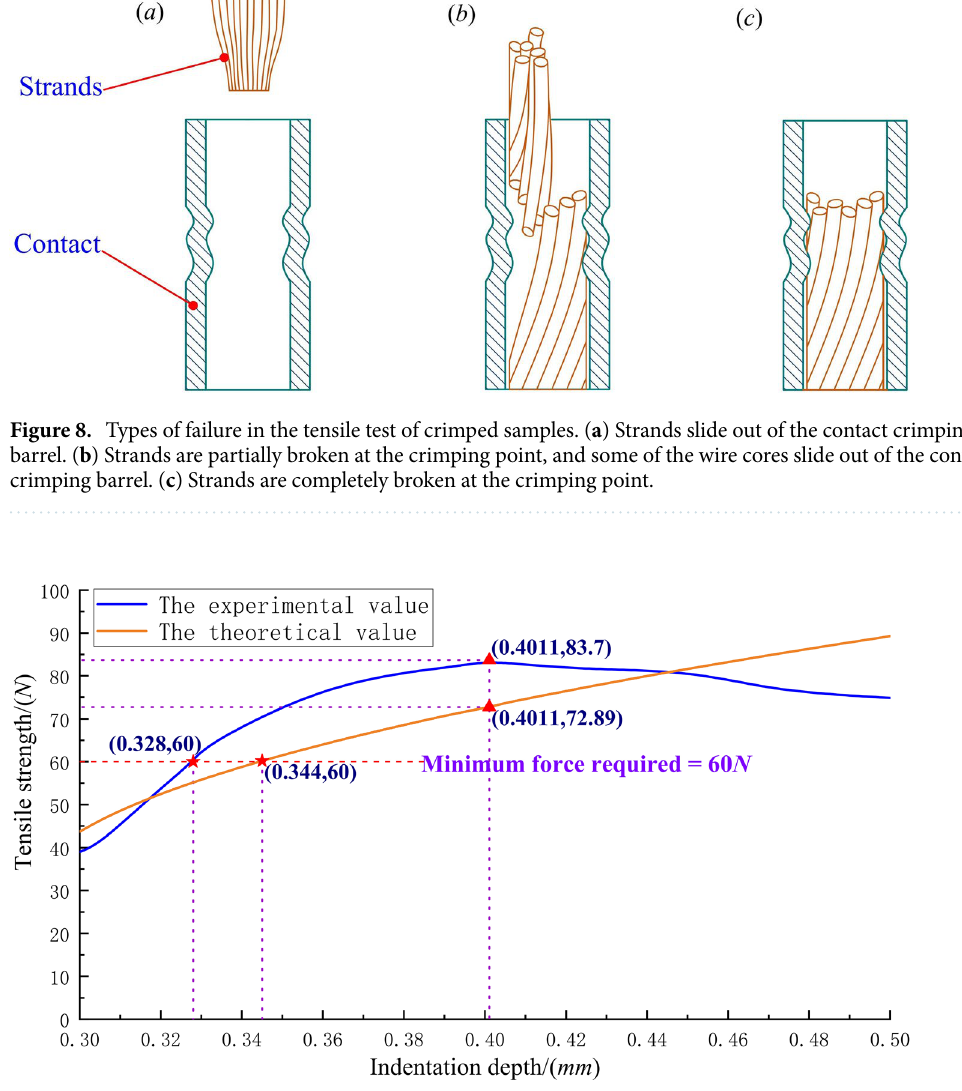
Figure 9. Tensile strength of crimping assembly that varies with indentation depth: the experimental and theoretical values.